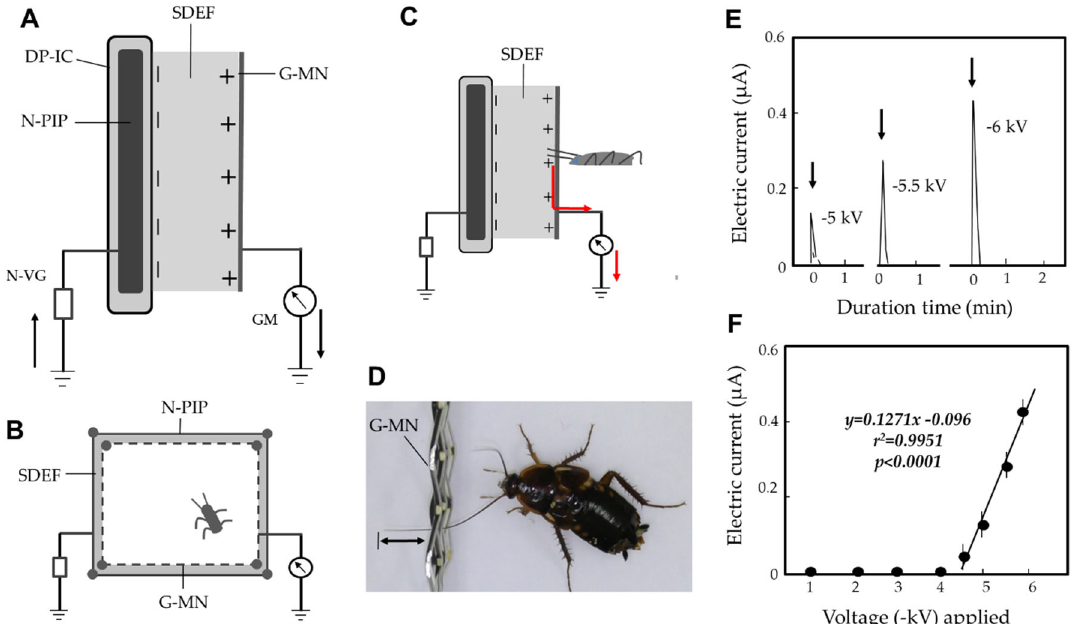
Figure 8. ( A ) Schematic representation of an SDEF producer (SDEFP) in cross-sectional view. ( B ) A square surrounded by four SDEFPs was used to examine insect avoidance behavior (bird’s-eye view). ( C ) Flow of a transient electric current (red arrow) from an insect that inserted its antennae into the EF. ( D ) Insertion of the antennae by cockroaches into the EF of the SDEFP charged at a voltage of − 4.5 kV. Arrow indicates the distance of antenna insertion from the G-MN (stainless steel). ( E ) Profiles of transient electric currents from discharges of adult Turkestan cockroaches that inserted their antennae into the EF of an SDEFP negatively charged with different voltages. ( F ) Relationship between the applied voltage and magnitude of the transient electric current. Means and standard deviations were calculated from five repetitions of the experiments. DP-IC, dielectrically polarized insulator coating with negative charge on outer surface; N-PIP, negatively charged PVC-insulated iron plate; N-VG, negative voltage generator; SDEF, single-charged dipolar electric field; G-MN, grounded metal (stainless steel) net; GM, galvanometer [29].